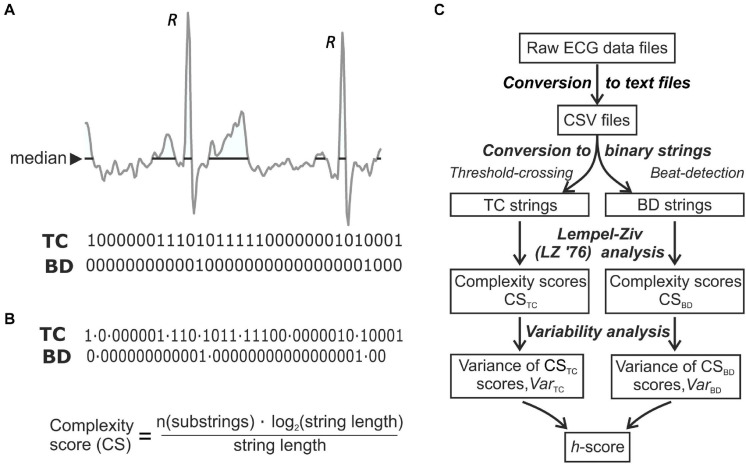
ECG analysis techniques. (A) The two methods to convert a digitised ECG recording to a binary string. Threshold Crossing (TC) substitutes “1” for all values equal to or above a median threshold and sets all other values to “0.” Beat Detection (BD) sets all values of a binary string to zero except at time-points where the R-wave peak is detected; to R-waves are marked on the trace. (B) The binary strings were split into a set of unique substrings (LZ’76 complexity analysis); the final complexity score was normalized to the length of the recording. (C) Flowchart of ECG processing to obtain a final discriminating h-score.